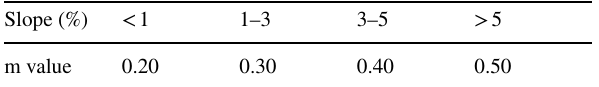
Table 4 m value for slope length and steepness factor